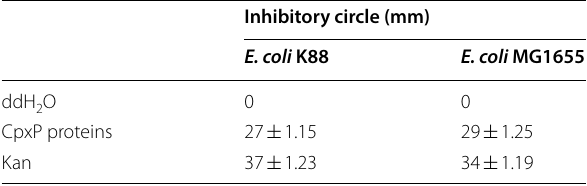
Values are the mean